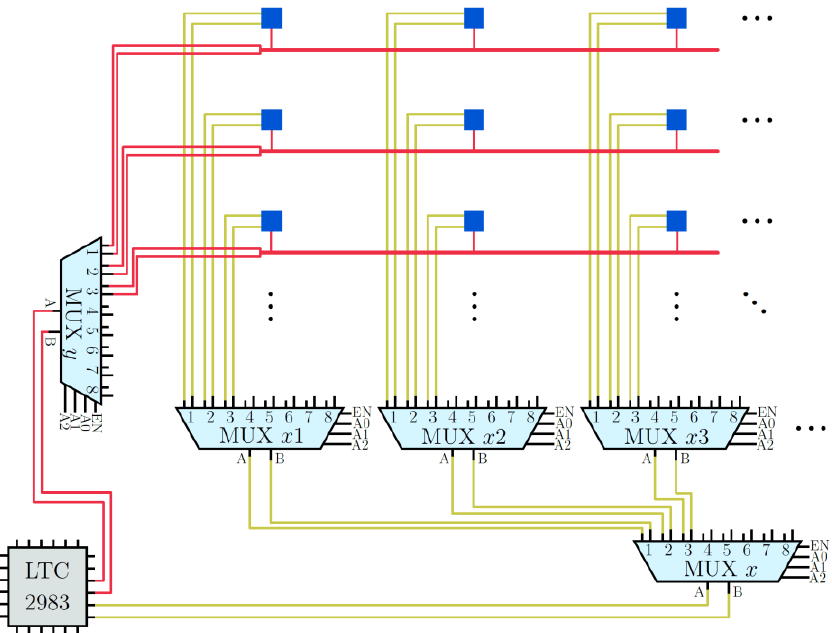
Figure 13. Simplified circuitry of analog multiplexers for the temperature sensor array in four-terminal sensing. To select the column ( x , green) and row ( y , red) of a dark blue temperature sensor, two 8 × 2 multiplexers are used. For the explicit selection of one temperature sensor, each column needs an additional 8 × 2 multiplexer.